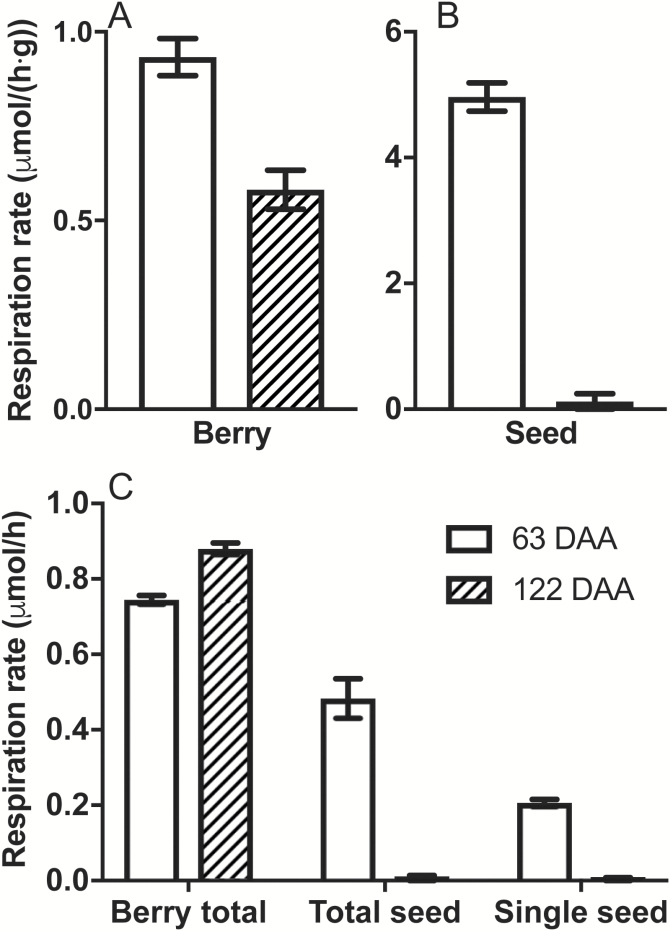
Chardonnay berry and seed respiration (25 °C) at 63 and 122 DAA in the 2015–2016 season. Respiration on a per gram fresh weight basis for berries (A) and seeds (B). (C) Comparison of respiration rates on a per berry basis (including seeds), total seed basis, and single seed basis. Data are means ±SE, n=3. All rates are different between 63 and 122 DAA (t-test, P<0.05).